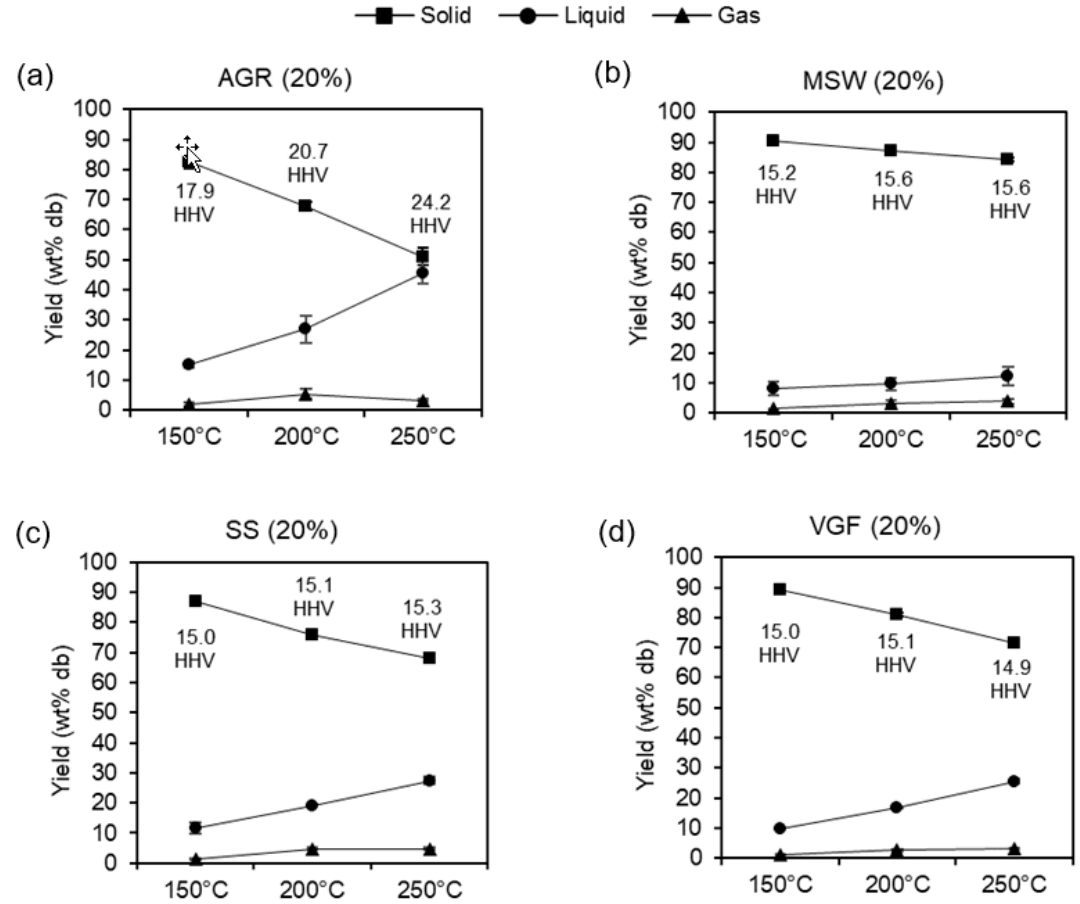
Figure 1. Influence of temperature on product yields including energy content of hydrochar at 20% loading for ( a ) agricultural residue (AGR), ( b ) municipal solid waste (MSW), ( c ) sewage sludge (SS), and ( d ) vegetable, garden and fruit (VGF) on a dry basis (db), based on duplicate data and error bars represent deviation around the mean .